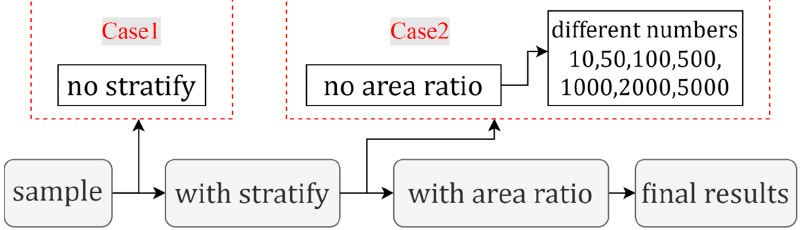
Figure 5. Comparison results with the different sampling experiments.